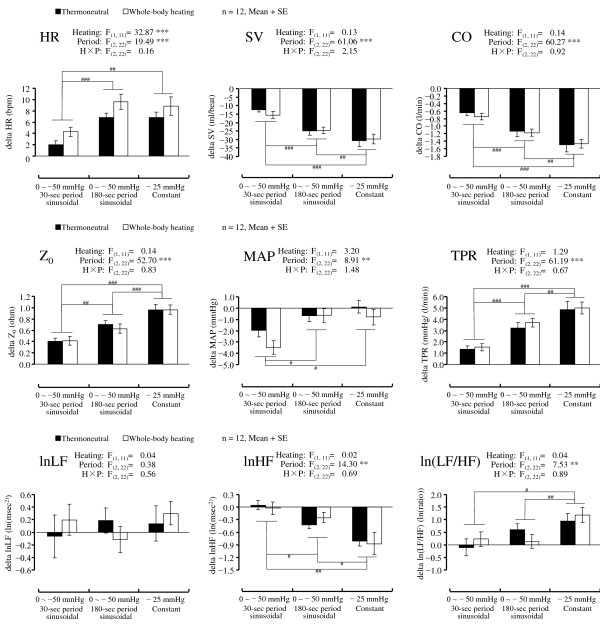
Differences in mean values (+SE) from baseline to LBNP in HR, SV, CO, Z0, MAP, TPR, lnLF, lnHF, and ln(LF/HF) of HRV. ***P <0.001, **P <0.01, *P <0.05 significant difference in ANOVA. ###P <0.001, ##P <0.01, #P <0.05 significant difference in simple main effect of period condition. in each heating condition.